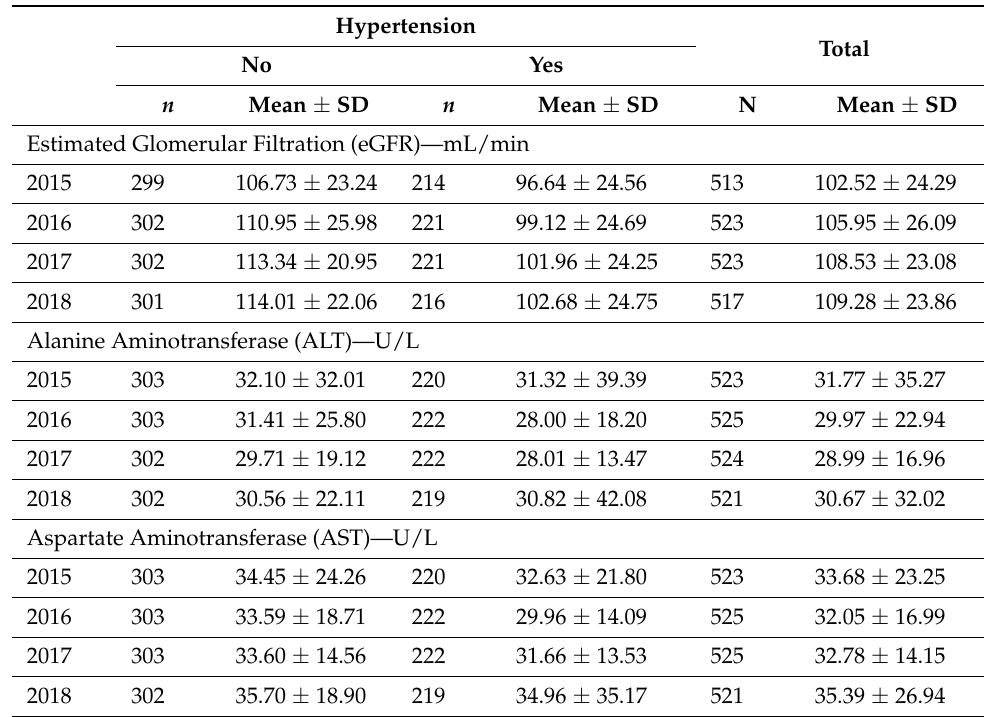
Table 2. ART Toxicity Related Outcomes.